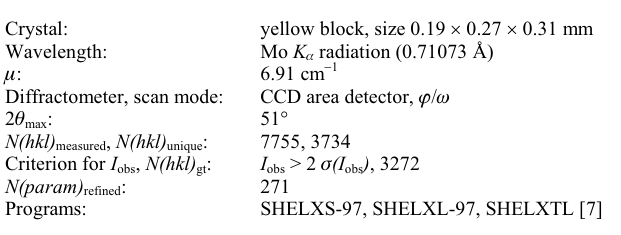
Table 1. Data collection and handling.